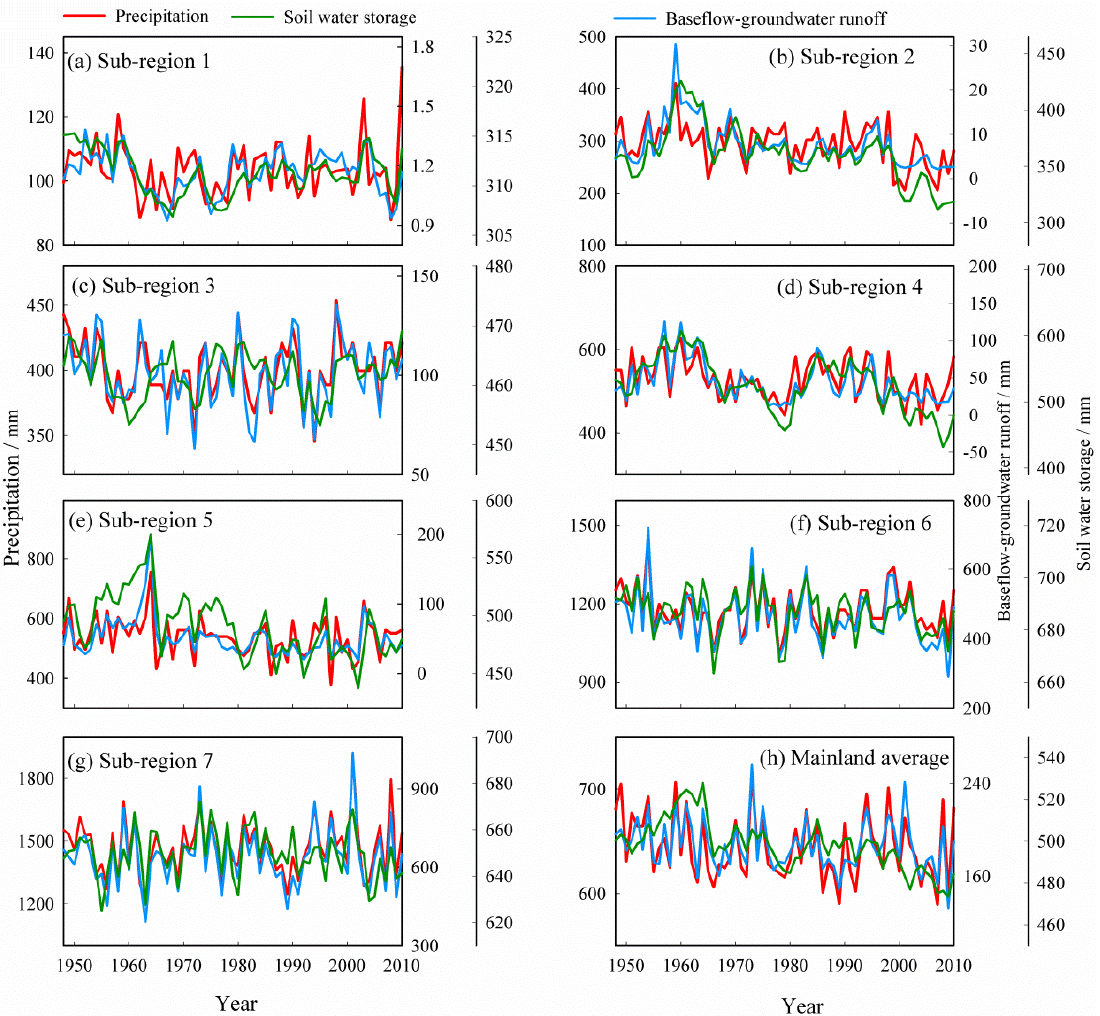
Figure 4. The variations of annual precipitation, soil water storage, and baseflow-groundwater runoff for different sub-regions and mainland China over 1948–2010.